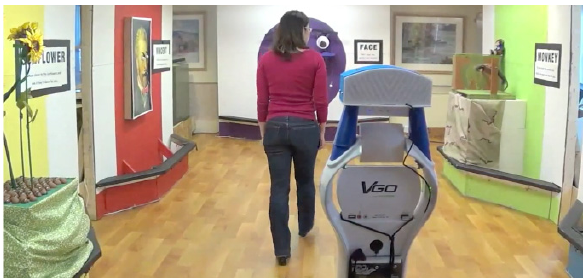
Fig. 2. The art gallery contained five interactive Artbotics exhibits: (left to right) Sunflower (yellow background), Vincent (red back- ground), Face (purple), Monkey (green background), and Music (not shown, blue background).